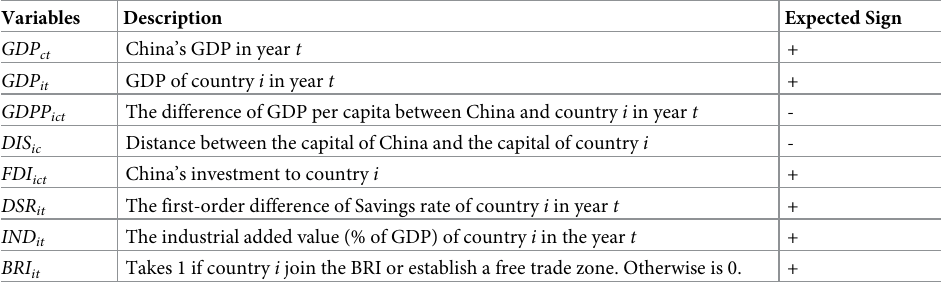
Table 4. The description of variables and expected